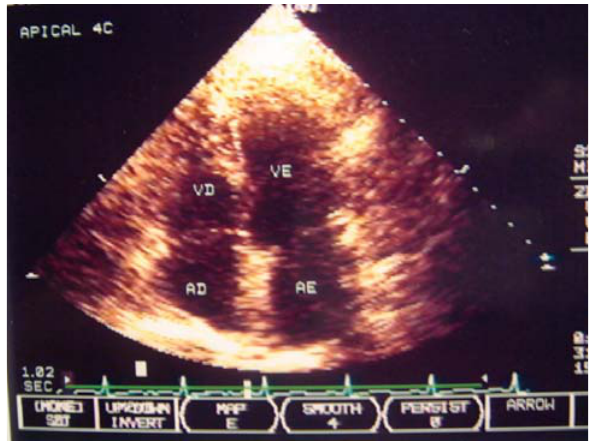
Fig. 2 - Ecocardiograma no 20 o dia de